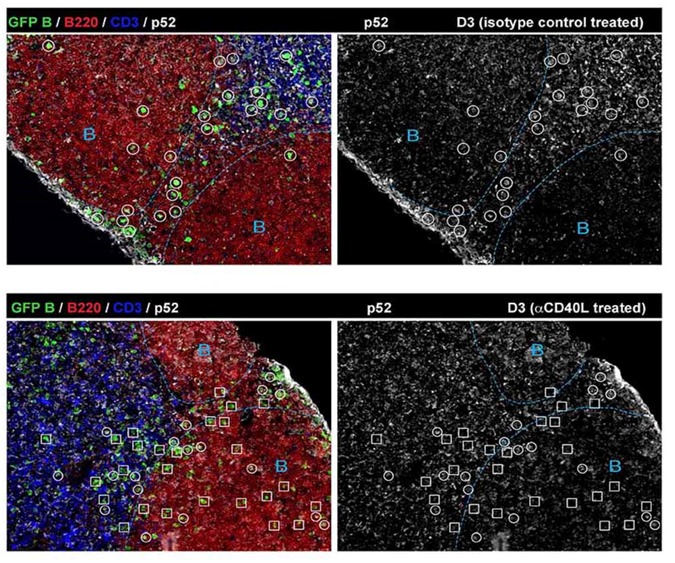
DOI:
http://dx.doi.org/10.7554/eLife.19552.018